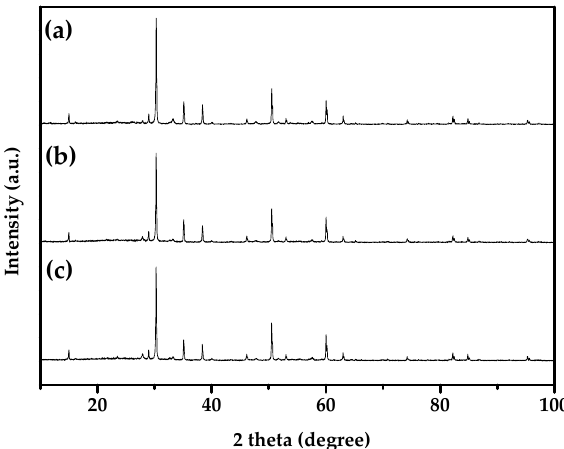
Figure 3. X-ray diffraction patterns of: ( a ) BiYTi 2 O 7 -1%PANI; ( b ) BiYTi 2 O 7 -5%PANI; and ( c ) BiYTi 2 O 7 -10%PANI.